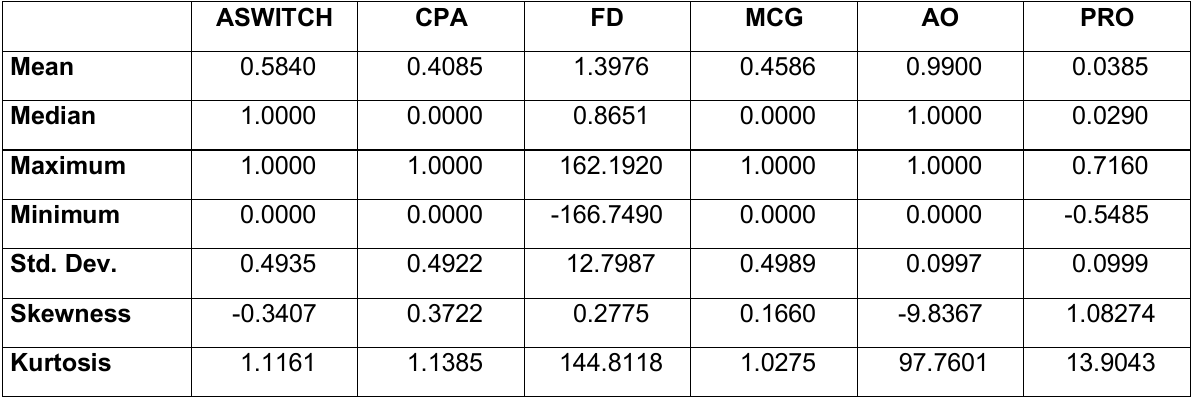
Table 2: Descriptive Data